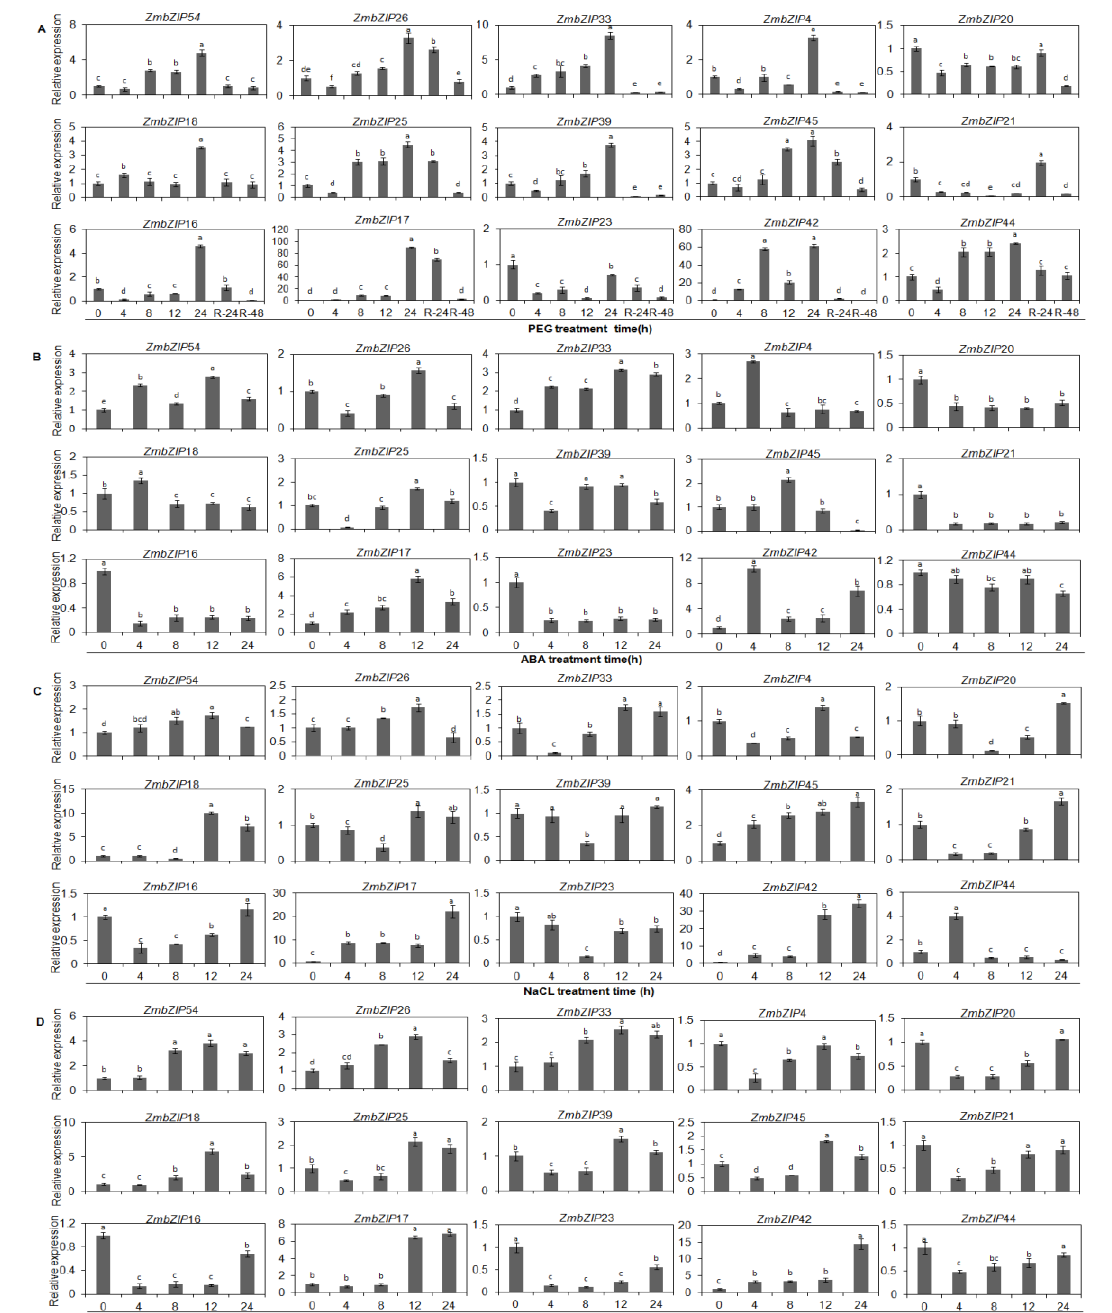
Figure 10. Expression patterns of ZmbZIP genes in response to drought, NaCl, ABA, and 37 ◦ C treatments. The relative expression level of 15 ZmbZIP genes was examined by the qRT-PCR. ( A ) Relative expression of 15 ZmbZIP genes under PEG treatment at 0 h, 4 h, 8 h, 12 h, 24 h and rewatering at 24 h and 48 h; ( B ) Relative expression of 15 ZmbZIP genes under NaCl treatment at 0 h, 4 h, 8 h, 12 h, 24 h; ( C ) Relative expression of 15 ZmbZIP genes under abscisic acid (ABA) treatment at 0 h, 4 h, 8 h, 12 h, 24 h; and ( D ) Relative expression of 15 ZmbZIP genes under 37 ◦ C treatment at 0 h, 4 h, 8 h, 12 h, 24 h. The error bars represent standard deviations (SD), y -axes are scales of relative expression level, and x -axes are the time course of treatments for each condition. Di ff erent lowercase letters indicate significant di ff erences at p < 0.05 (Duncan’s